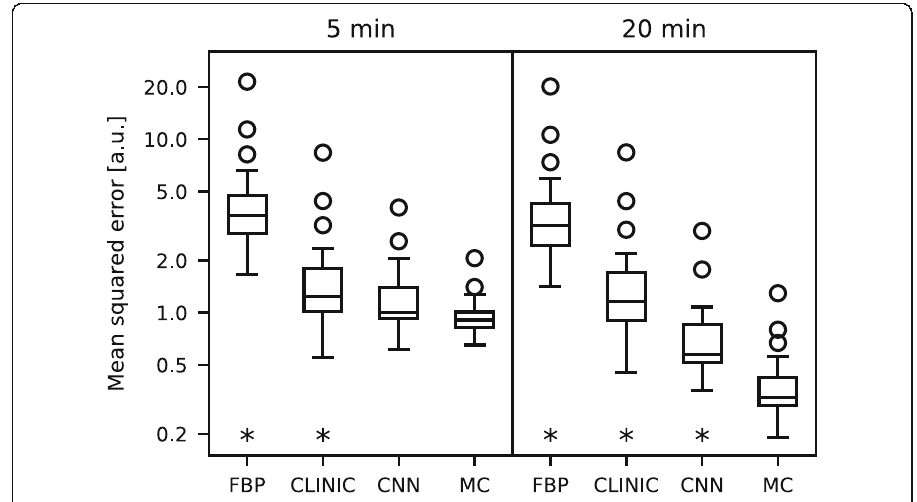
different from the Monte Carlo-based reconstruction (Mann-Whitney U test at p < 0.01)